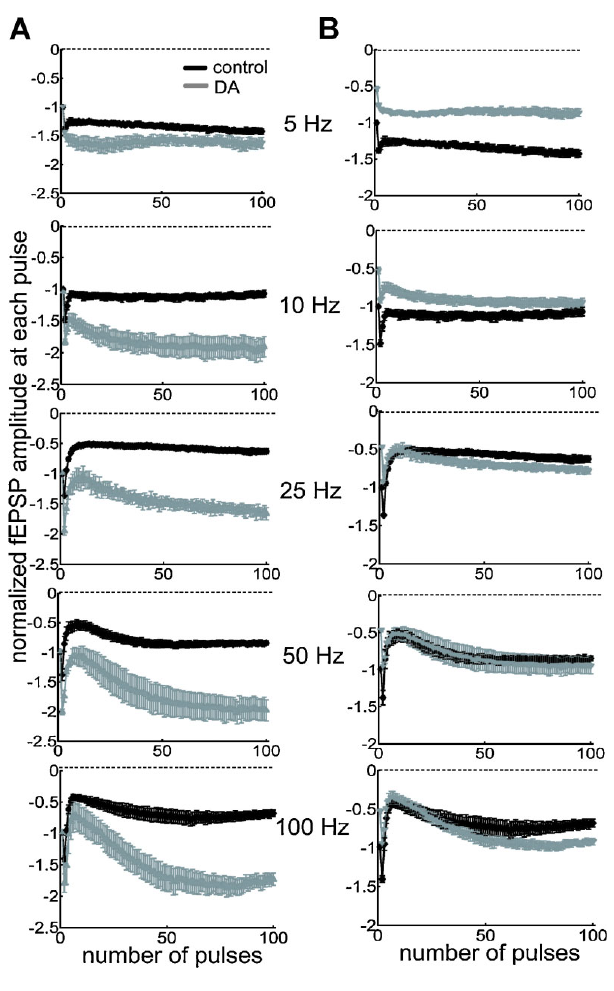
Figure 5. High-pass filtering of TA-CA1 synaptic efficacy by DA . ( A ) Examination of frequency-dependent modulation by DA, using extracellular fieldrecordings.Pulses(100)ofdifferentstimulationfrequencies,asindicated, were applied. Data were normalized to the baseline fEPSP amplitude prior to stimulation and each mean fEPSP amplitude during 100pulse stimulation was plotted (from top to bottom; control: n = 5, 5, 7, 6, and 5, DA: n = 5, 5, 5, 5, and 5). ( B ) Same data as in A , but normalized to the baseline fEPSP amplitude before, instead of after, DA